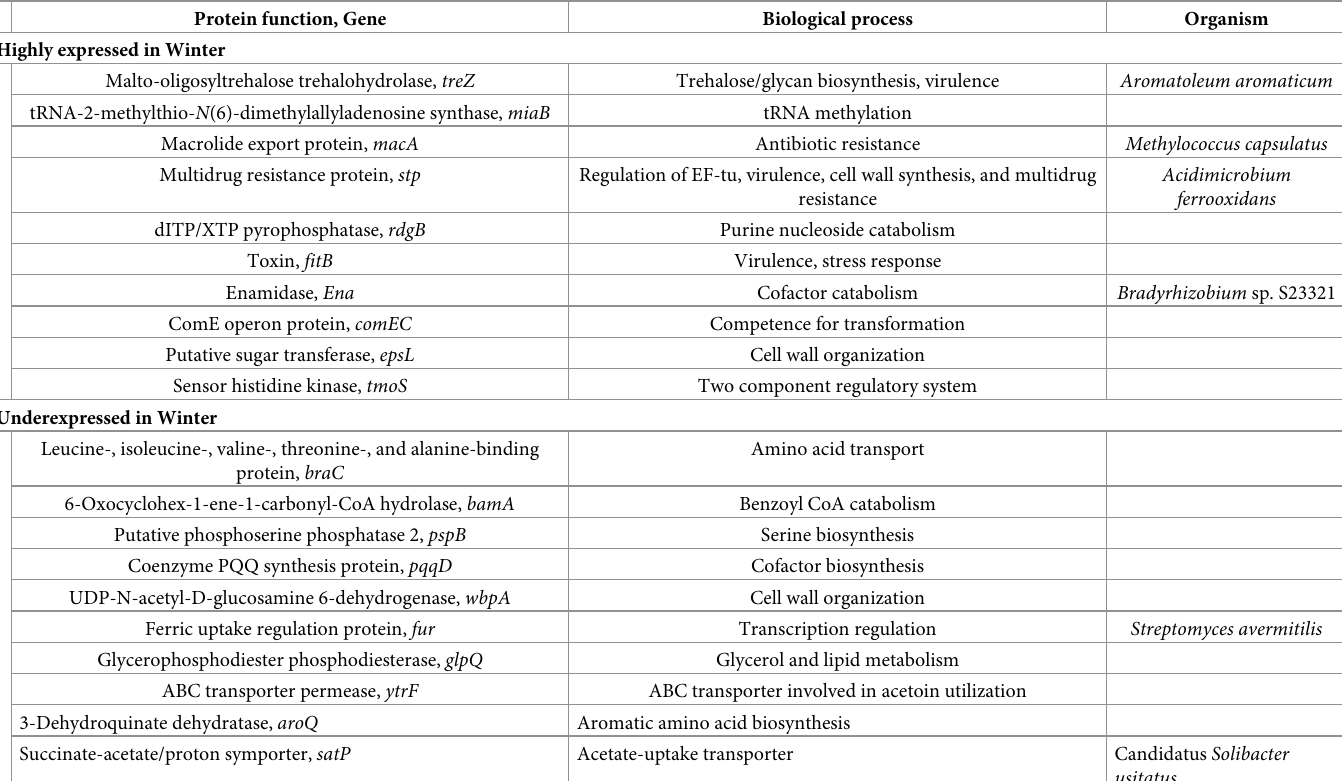
Table 3. Seasonal gene expression. Protein function,